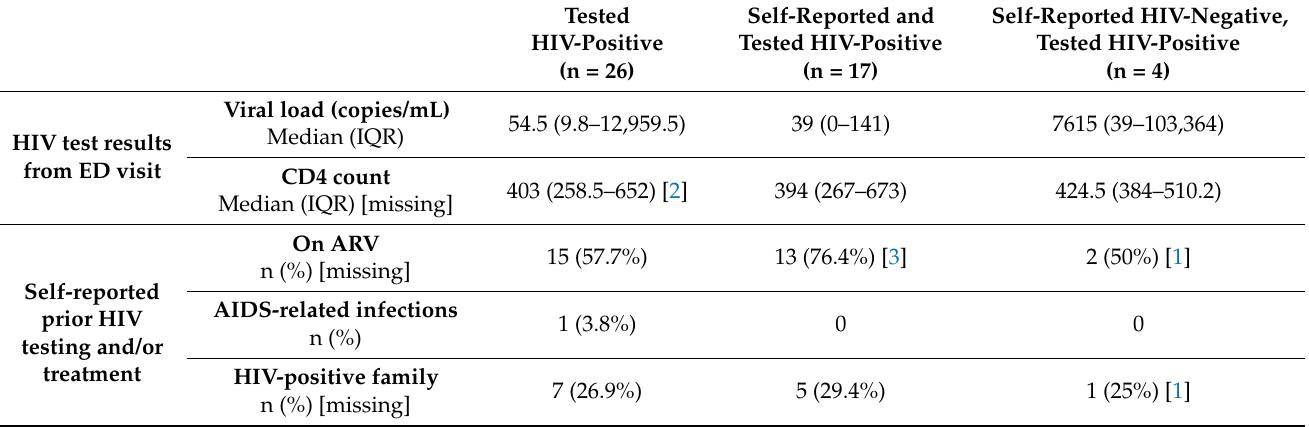
Table 2. Testing characteristics of ED injury patients with HIV-positive status (‘n’ indicates number of patients). Self-Reported HIV-Negative, Self-Reported and Tested Tested Tested HIV-Positive HIV-Positive (n = 17) (n = 26)